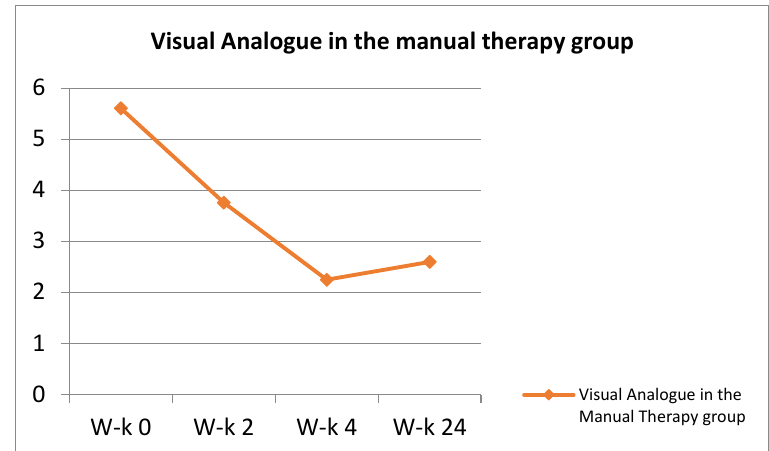
Figure 3. Visual Analogue in the manual therapy group.